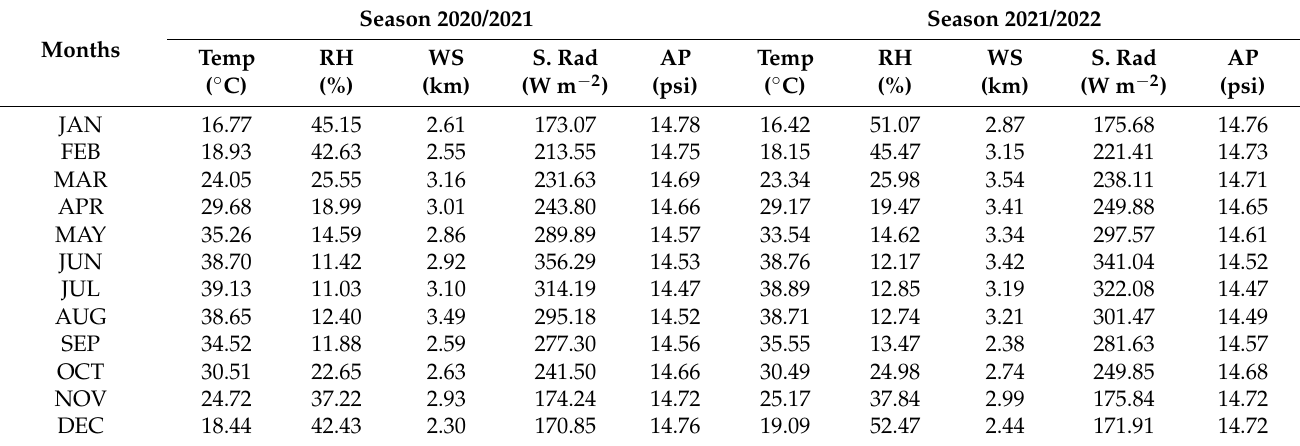
Table 7. Average monthly values of the temperature (Temp), relative humidity (RH), wind speed (WS), solar radiation (S. Rad), and air pressure (AP) of Al-Qassim region, KSA, during the